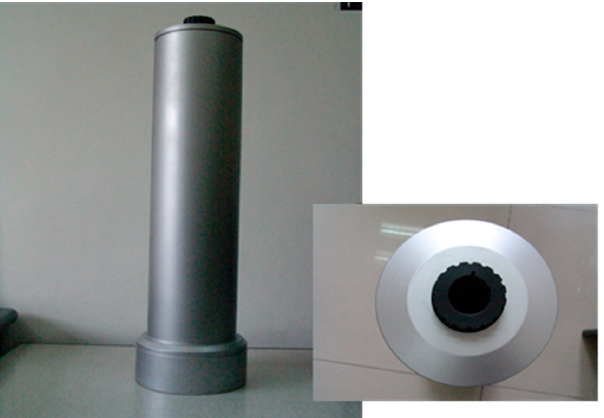
Figure 4. Photos of the adapter of 102F FTIR spectrometer taken, respectively, from the side and from above.